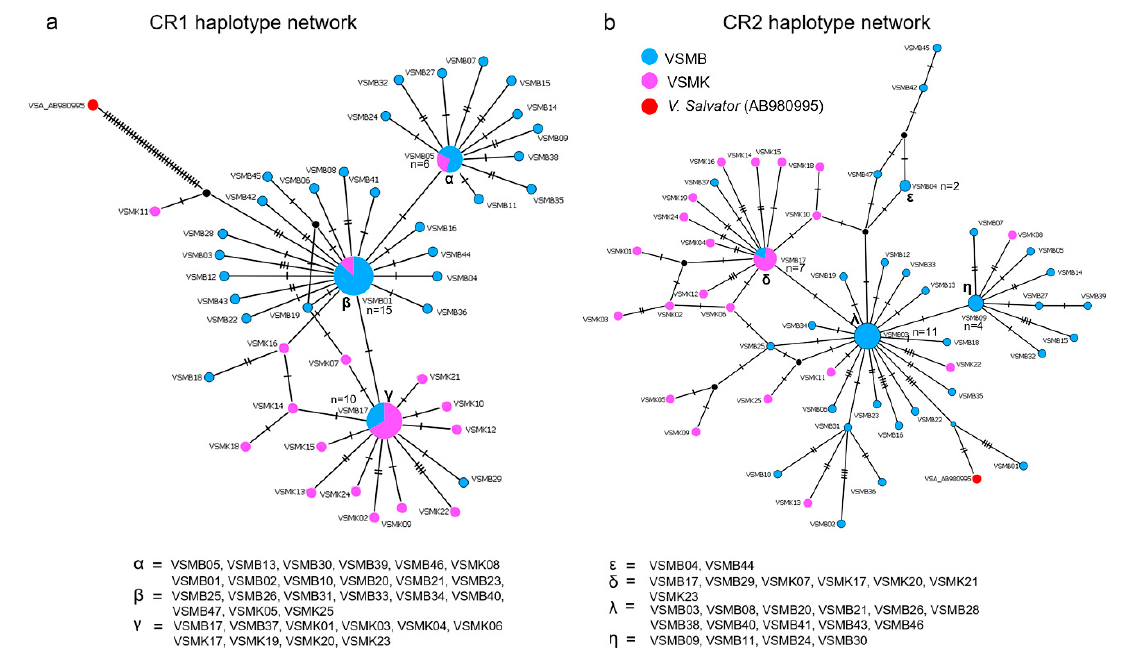
Figure 2. Haplotype network based on mitochondrial control region (mtCR) region sequence data of water monitors from Bang Kachao Peninsula (VSMB) and Varanus Farm Kamphaeng Saen (VSMK) populations, constructed using statistical parsimony with the TCS network. The numbers of individuals possessing haplotypes are indicated by different colors inside the circles. Missing haplotypes are indicated by black circles. ( a ) mtCR1 haplotype network ( b ) mtCR2 haplotype net-